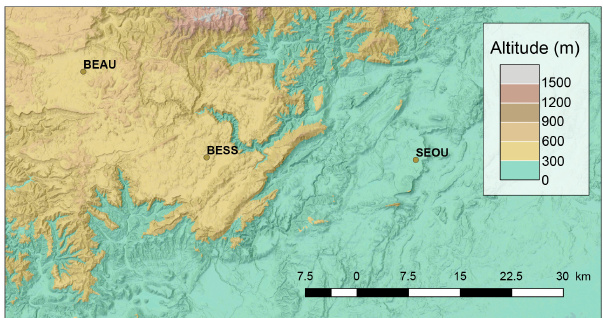
Figure 1. Topographic map (elevation in metres) with the three sites